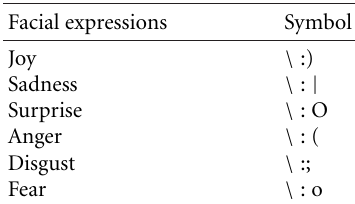
Table 1: Facial expressions and corresponding symbols in the TTS system.